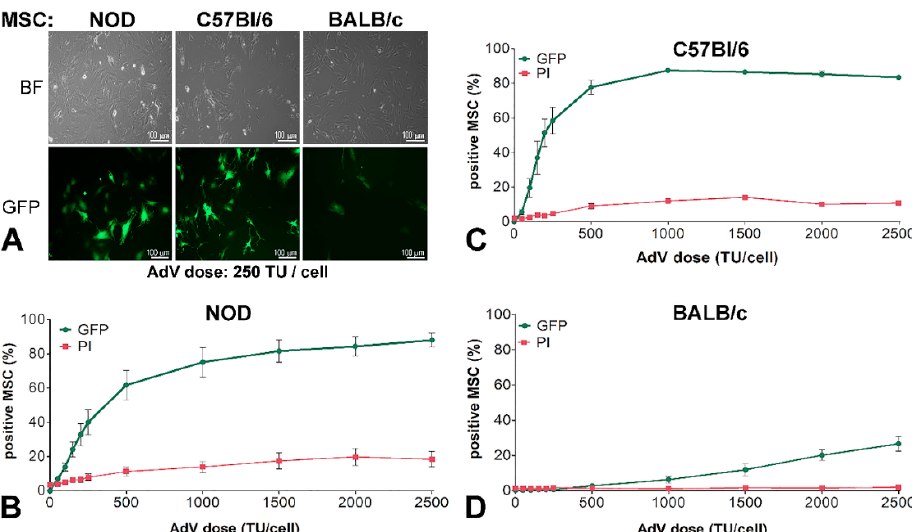
Figure 1. Adenoviral transduction efficiency of murine mesenchymal stromal cells (MSC) isolated from three mouse strains. ( A ) Microscopy of non-obese diabetic NOD-MSC, C57BL/6-MSC, and BALB/c-MSC, transduced with 250 transduction units (TU)/cell adenovirus for GFP expression: BF—Bright field and GFP—fluorescence microscopy. ( B – D ) Dose-dependent transduction of MSC derived from NOD, C57BL/6, and BALB/c strains. The cells were incubated with increasing doses of adenovirus ranging from 0–2500 TU/cell; after 48 h the GFP expressing cells and the cell death determined by propidium iodide (PI) incorporation were evaluated by flow cytometry. The dose-dependent curves are different for NOD-MSC ( B ), C57BL/6-MSC ( C ), and BALB/c-MSC ( D ).